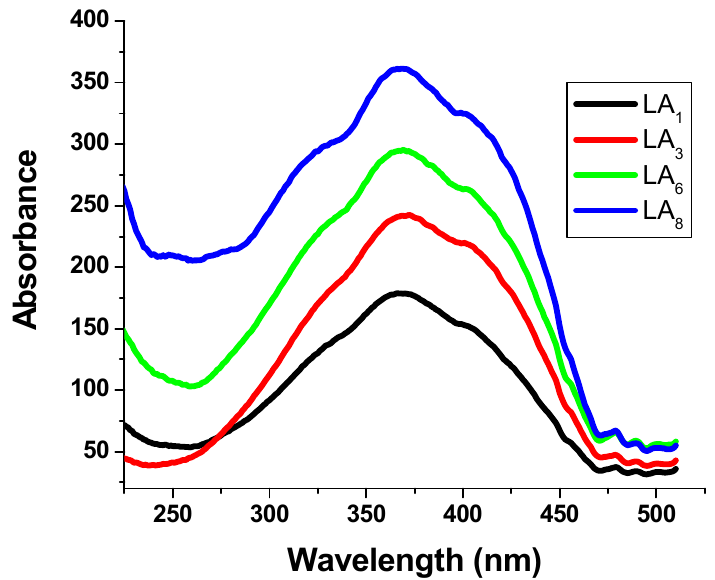
Figure 4. Excitation spectra of LANPs-loaded GLS@PET at 518 nm.